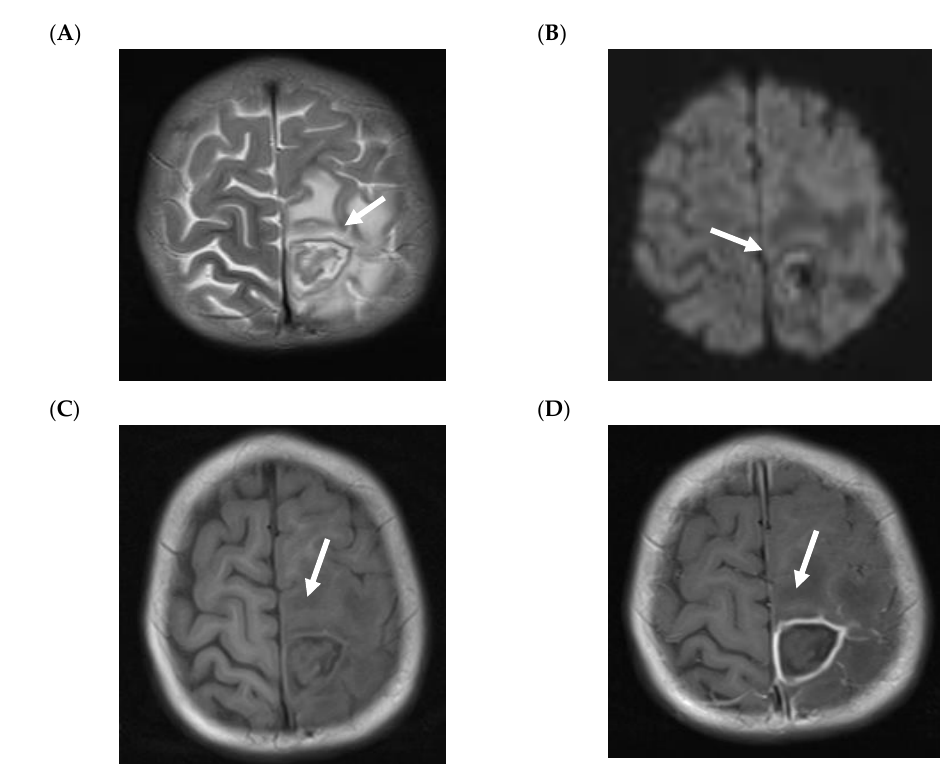
Figure 3. Fungal abscess in a 3-year-old girl with acute lymphoblastic leukemia and proven central nervous system invasive mold infection. The patient is alive with residual right-sided weakness. Axial T2-weighted ( A ) shows a mass in the left central region, which is predominantly of low T2 signal intensity, centrally with hyperintense perilesional edema and a well-defined ring-like hypointense area (arrow). Diffusion-weighted image (DWI), b = 1000 s/mm 2 , shows mainly restriction within the hypointense rim ( B , arrow). Axial unenhanced T1-weighted shows a slight rim-like high signal intensity probably due to the presence of iron, manganese or methemoglobin ( C , arrow). T1 after contrast shows a strong ring enhancement ( D , arrow).